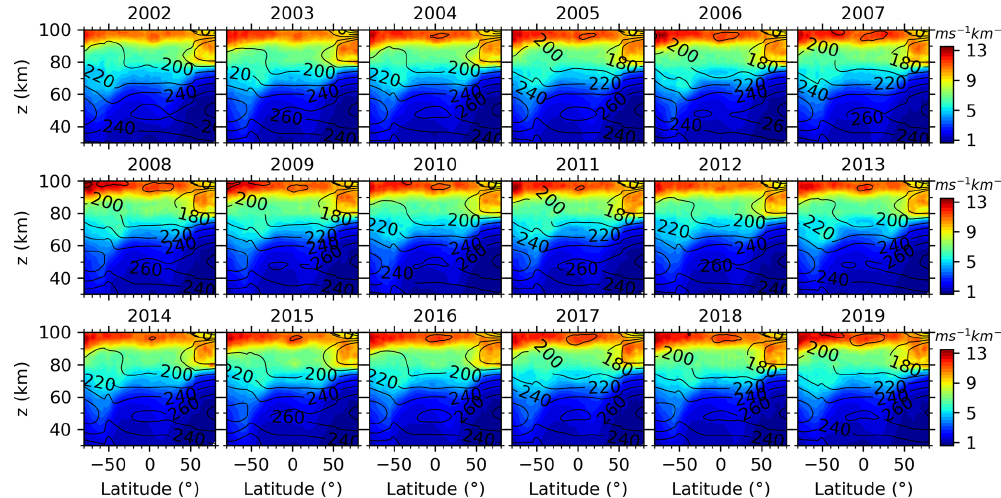
Figure 16. Same as Fig. 8 but for the GW-perturbed shears derived under the medium-frequency assumption f/ ˆ ω j = 0.